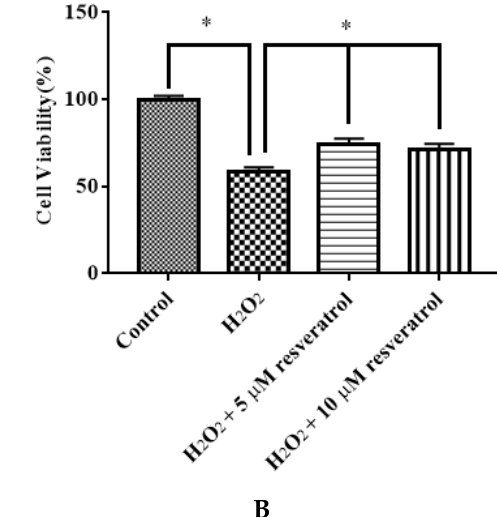
A B Figure 5. Effects of resveratrol on the viability of IDECs. ( A ) IDECs cells were incubated with increasing concentrations of resveratrol for 6 h. * p < 0.05 compared to 0 μM resveratrol. ( B ) IDECs were pretreated with the resveratrol (5 μM and 10 μM) and then cocultured with 400 μM H 2 O 2 for 6 h. Then cell viability was measured by CCK-8 assays. The data were analyzed through one-way ANOVA and are expressed as the mean ± SE ( n = 3). * p < 0.05 compared to H 2 O 2 group. 3.5. Effect of Resveratrol on the Antioxidant Ability and Apoptosis of IDECs Exposed to H 2 O 2 To confirm that resveratrol protects against the H 2 O 2 -induced oxidative stress damage of IDECs, ROS, MDA, CAT and GSH-PX levels were determined in 400 μM H 2 O 2 -treated IDECs pretreated with 5 μM resveratrol. Pretreatment with resveratrol for 6 h reduced ROS production in IDECs under oxidative stress ( p < 0.05) (Figure 6A). The addition of 5 µ M resveratrol significantly reduced the MDA level and markedly increased the CAT level compared with the H 2 O 2 -induced group (Figure 6B–D).